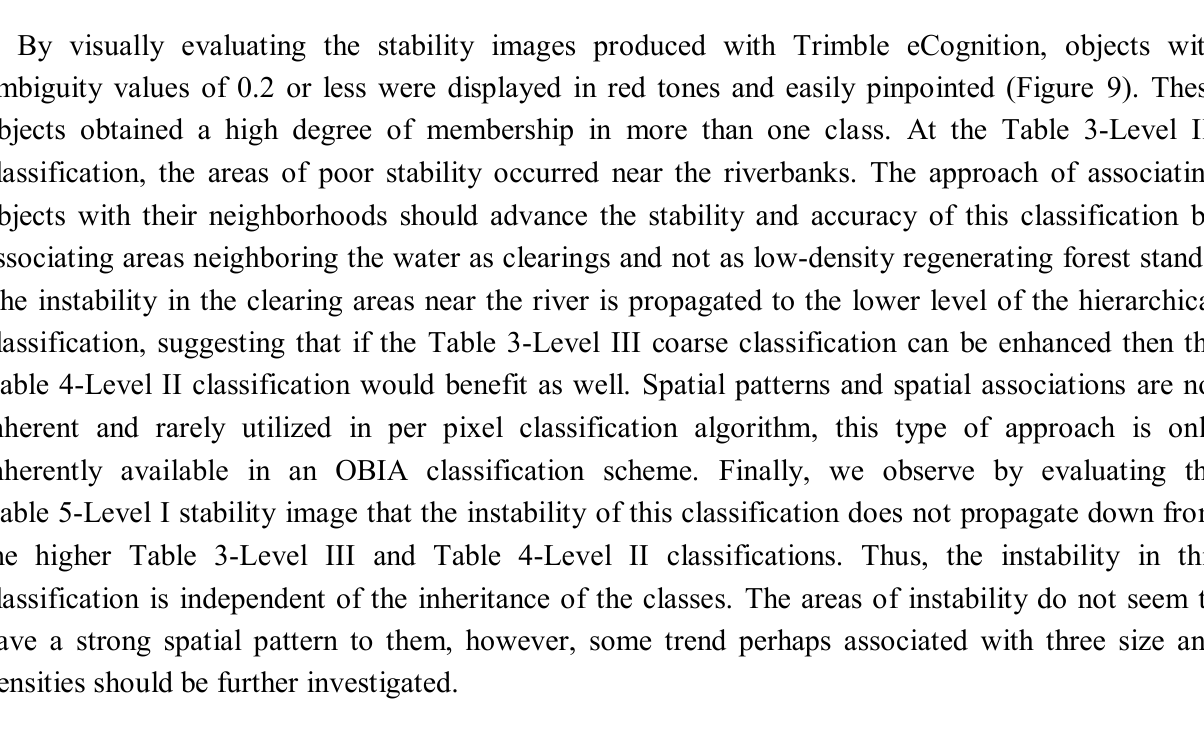
Figure 9. Visual analysis of classification stability; stability scale is a color ramp where dark green is non-ambiguous (1) and red is absolutely ambiguous